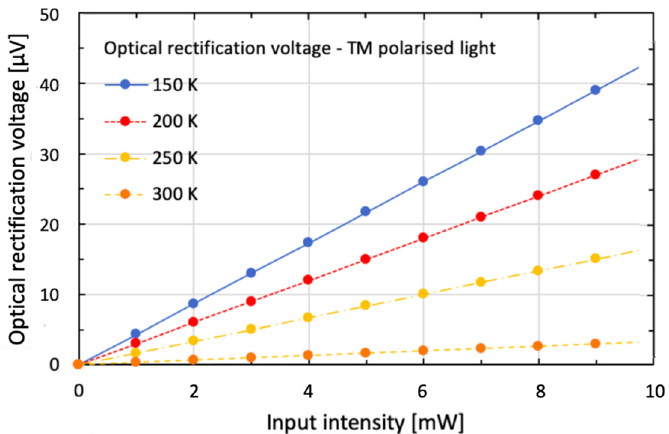
Figure 3. Optical rectification voltage of a 1.55 µm GaN/AlN-based SL detector as a function of input intensity for device temperatures of 150, 200, 250, and 300 K and an illumination level of 10 mW. These curves take into account a high ECS grating diffraction efficiency of 80%.